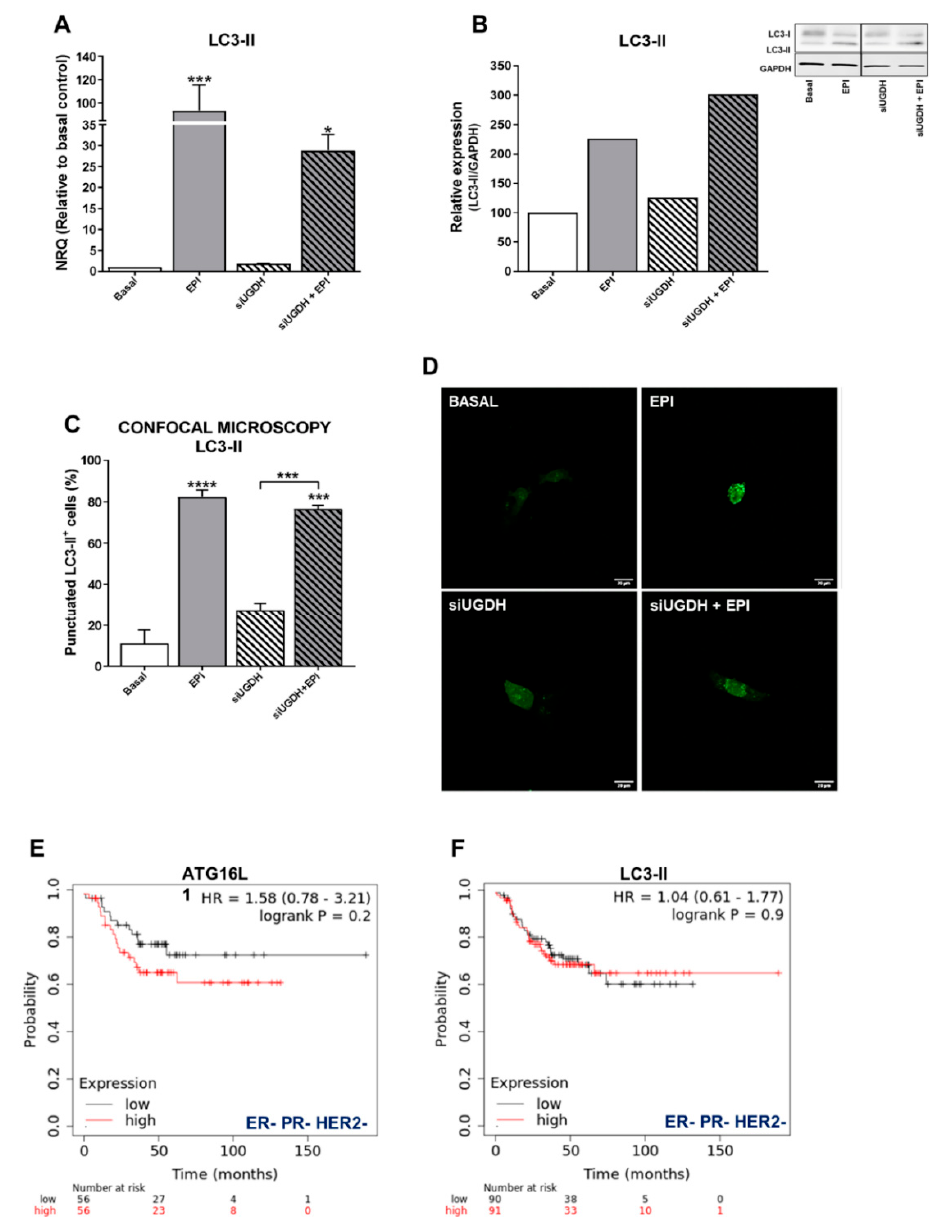
Figure 6. Analysis of autophagy as a mechanism involved in drug resistance. MDA-MB-231 cells were co-transfected with a specific siRNA against UGDH gene (siUGDH) or a random sequence siRNA as negative control (siSCR) and 2 µ g of a specific LC3-GFP construct. After 24 h, 1 µ M EPI (1 EPI) was added to complete 48 h of incubation. LC3-II expression ( A ) was determined by real-time quantitative PCR using SYBR Green. Results were normalized using β -actin as the reference gene and all determinations were performed as duplicates. Transformation of LC3-I in LC3-II was evaluated by Western blot, comparing both with GAPDH reference protein ( B ). To analyze the formation of autophagosomes, the fluorescence emitted by GFP was evaluated through confocal microscopy ( D ). The LC3-II puncta analysis was performed using the ImageJ software ( C ). n = 3, mean ± SEM, * p < 0.05 *** p < 0.001, **** p < 0.0001. The prognostic value of the expression of ATG16L1 ( E ) and LC3-II ( F ) in patients with breast cancer stratified by hormone receptor status. Kaplan–Meier relapse-free survival curves are plotted based on triple-negative expression of ER, PR, and HER2 treated with chemotherapy ( n = 181). Log-rank p values and hazard ratios (HRs; 95% confidence interval in parentheses) are shown. The corresponding Affymetrix IDs are: 232612_at_ATG16L1 and 208786_at_LC3 ‐ II.